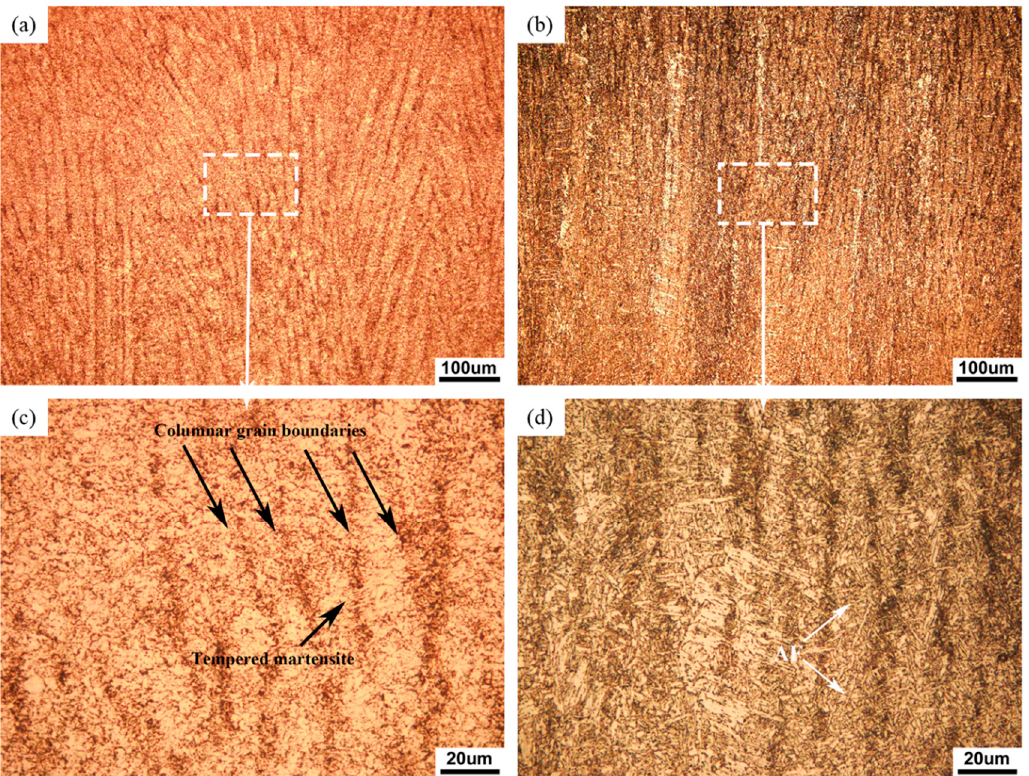
Figure 3. Optical microstructures in the columnar grain zone of weld metal:( a ) and ( c ) TIG, ( b ) and ( d ) SAW.